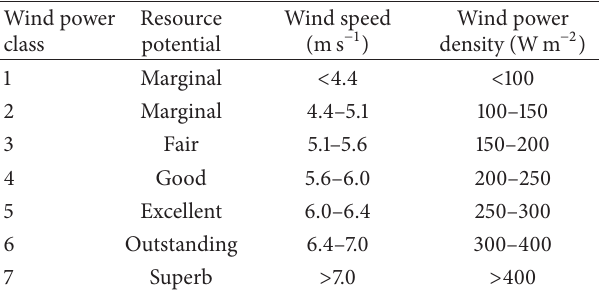
Table 1: Classifying wind energy at 10 meters based on wind speed (ms − 1 ), wind power density (Wm − 2 ), and overall wind resource